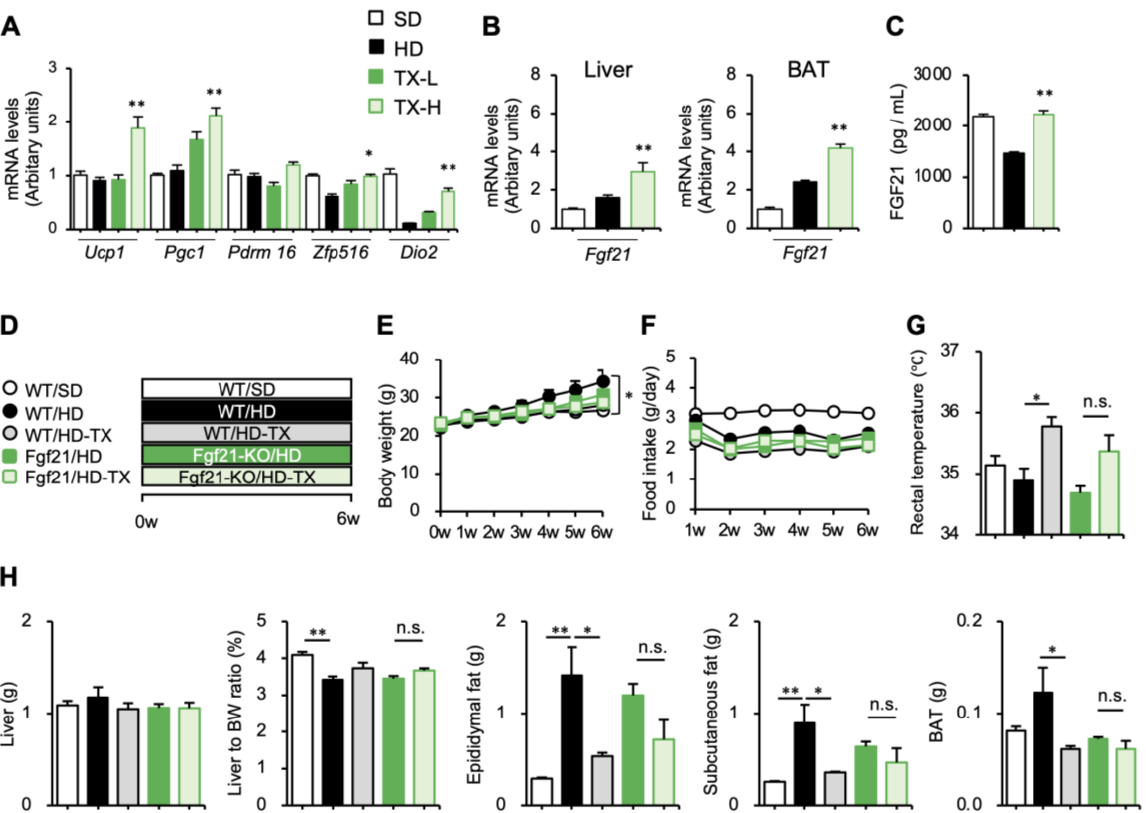
Figure 3. Involvement of Fgf21 in Taxifolin-mediated anti-obesity effects. ( A – C ) Male C57BL/6J mice were divided into the following 4 groups: white square, SD; black square, HD; dark-green square, TX-L; light-green square, TX-H. n = 6 in each group. ( A ) Expression levels of genes related to brown adipocyte activation ( Ucp1 , Pgc1 , Prdm16 , Zfp516 , and Dio2 ) in interscapular brown adipose tissue of the C57BL/6J mice fed an HD with or without Taxifolin for 12 weeks. ( B ) Expression levels of Fgf21 and Il6 mRNAs in the liver. ( C ) Serum Fgf21 concentrations after 12 weeks of HD feeding with or without Taxifolin. Mean ± SEM; n = 6; * p < 0.05 and ** p < 0.01 vs. HD. ( D – H ) Male C57BL/6J mice (wild-type, WT) and Fgf21-deficient mice (Fgf21-KO) were divided into the following 5 groups: white square, WT/SD; black square, WT/HD; gray square, TX/H; dark-green square, Fgf21-KO/HD; light-green square, Fgf21-KO/HD-TX-H. n = 6 in each group. ( D ) Experimental protocol: Fgf21 -deificient and wild-type mice were fed an HD with or without Taxifolin for 6 weeks; ( E ) growth curve; ( F ) food intake; ( G ) rectal temperature; ( H ) tissue weights: liver, liver-to-body weight ratio, epididymal fat, subcutaneous fat, and interscapular brown adipose tissue. Values are presented as the means; n = 5–6; significant differences: * p < 0.05 and ** p <